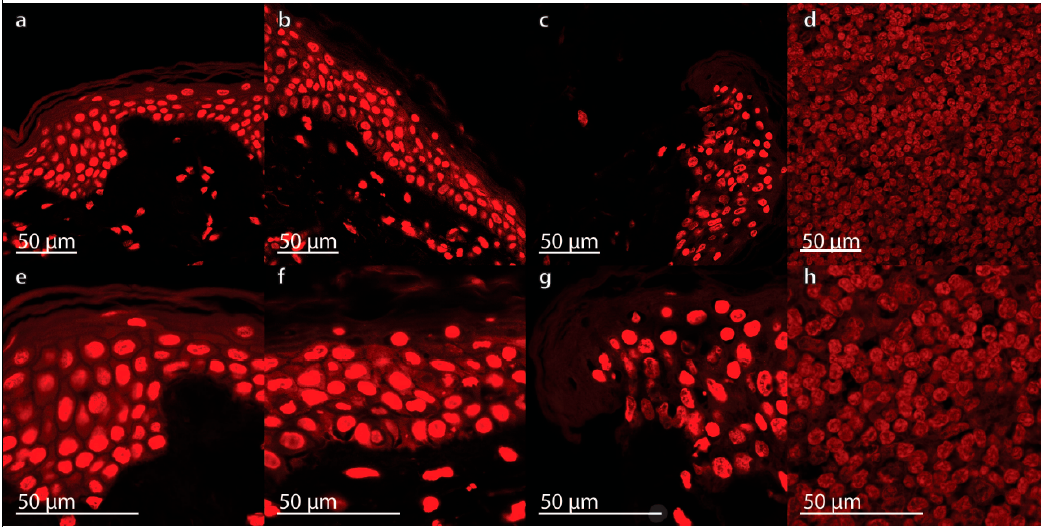
Figure 4. Propidium iodide (PI) staining in human full-thickness skin graft cross sections: No significant nuclear changes were detectable in the skin samples by PI-staining. A reference sample fixed at the day of surgery, 0 day ( a , e ), as well as a non-wounded ( b , f ) and wounded skin ( c , g ) sample cultured in organ culture medium for 10 days are shown. Palatine tonsil was used as positive control ( d , h ). All samples are shown in low ( a – d ) and high magnification ( e – h ). Taken together, the morphological investigations did not reveal any significant signs of necrosis.